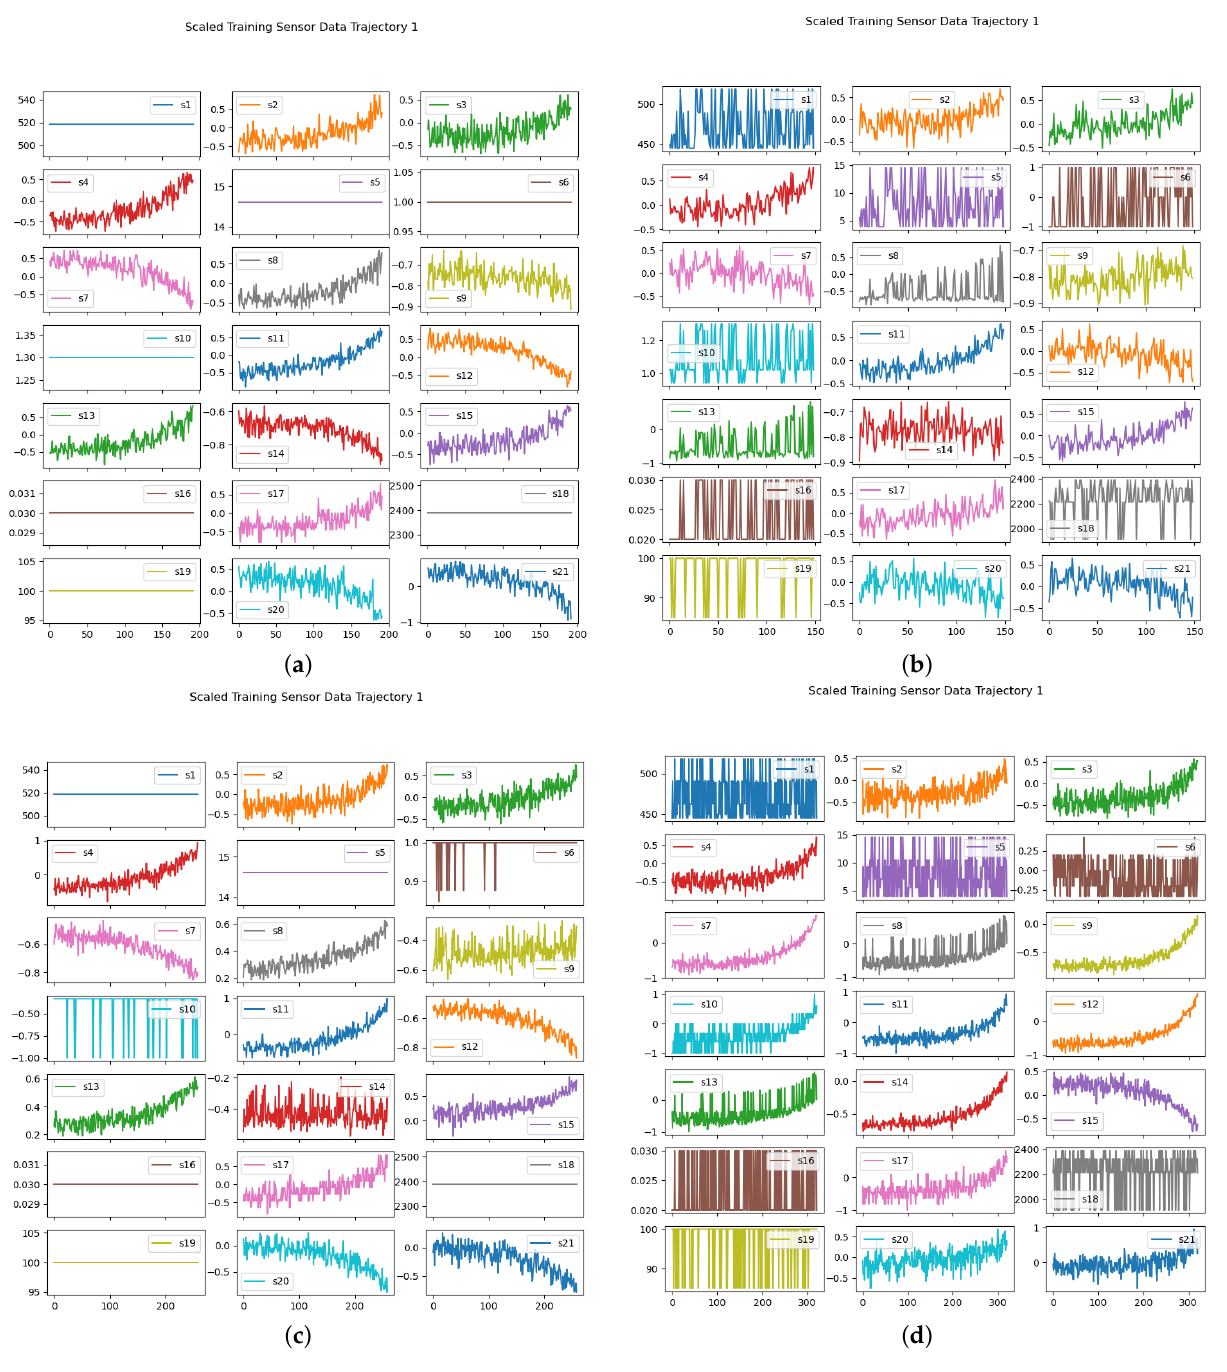
Figure 10. One-time degradation of full-cycle parameters for 21 sensors in four subsets. ( a ) FD001. ( b ) FD002. ( c ) FD003. ( d )